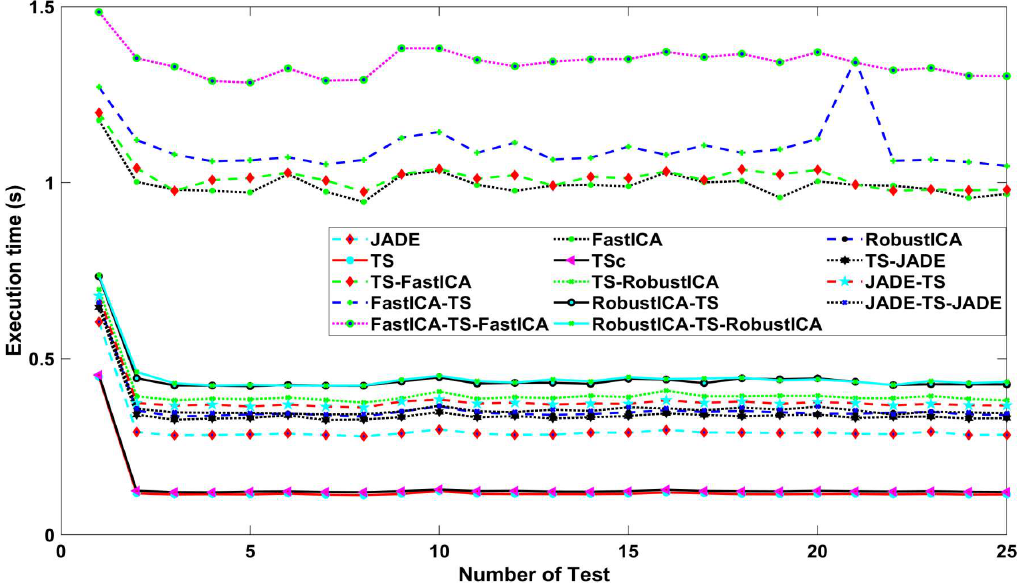
Figure 7. Time execution comparisons.